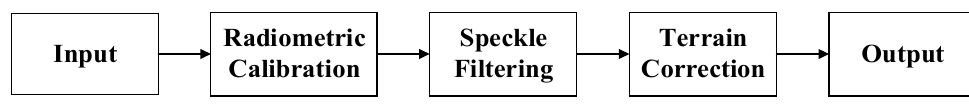
Figure 2. Preprocessing flowchart.